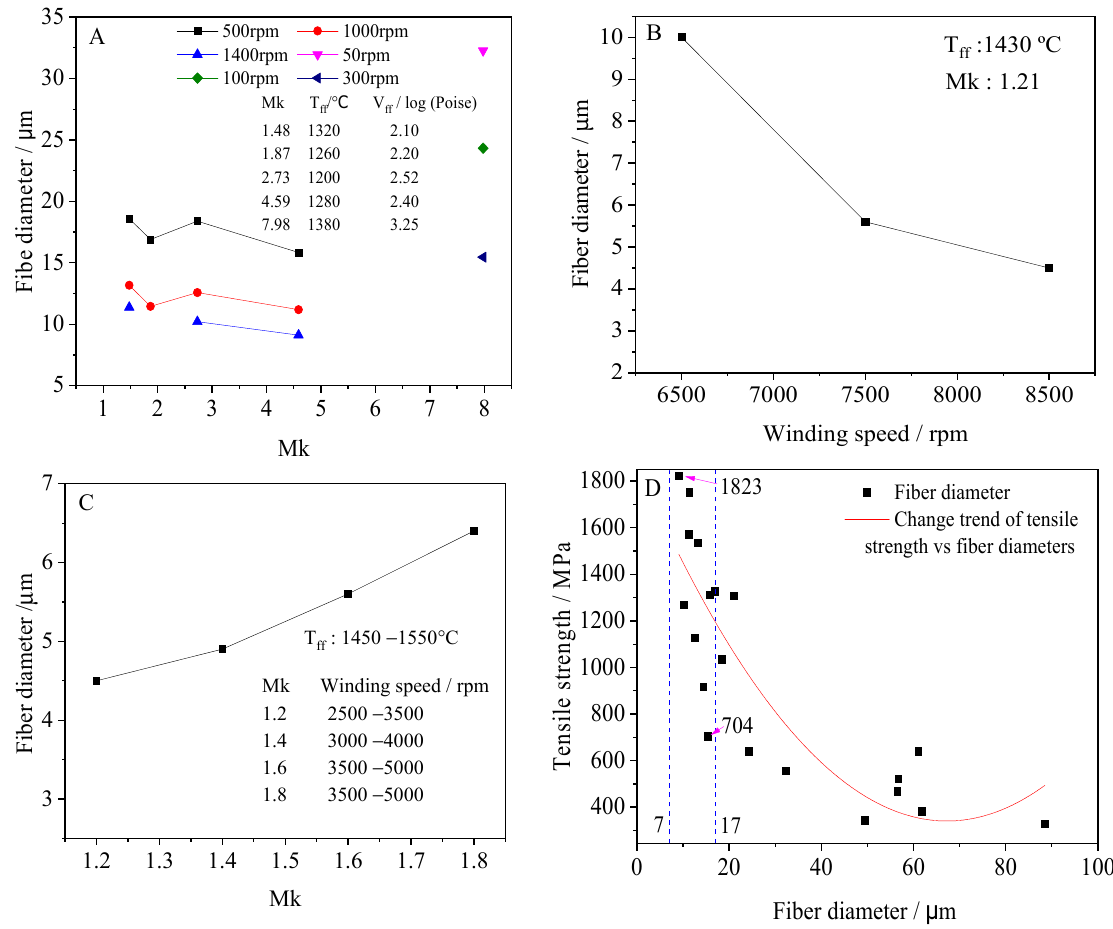
Figure 6. The relationship between tensile strength, diameter, Mk, and winding speed of fiber produced from solid wastes. ( A ) The relationship of Mk and the diameter of continuous fibers. ( B ) The relationship of winding speed and diameter of mineral fibers. ( C ) The relationship of Mk and the diameter of mineral fibers. ( D ) The relationship of tensile strength and diameter of continuous fibers. The above data in figures from (Kim et al., 2018; Ko et al., 2021; Li et al., 2018; Chan et al., 2017)